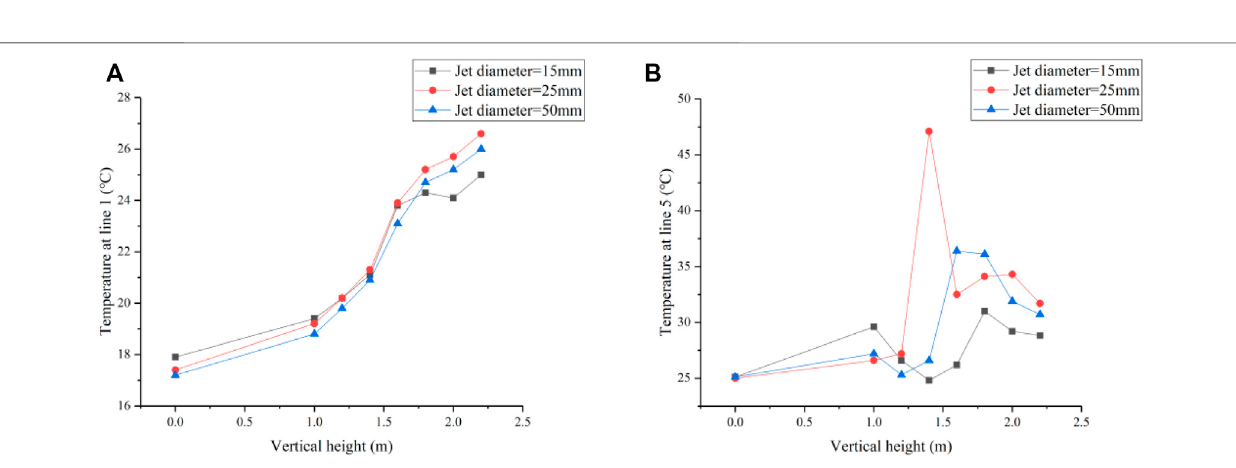
Frontiers in Energy Research |